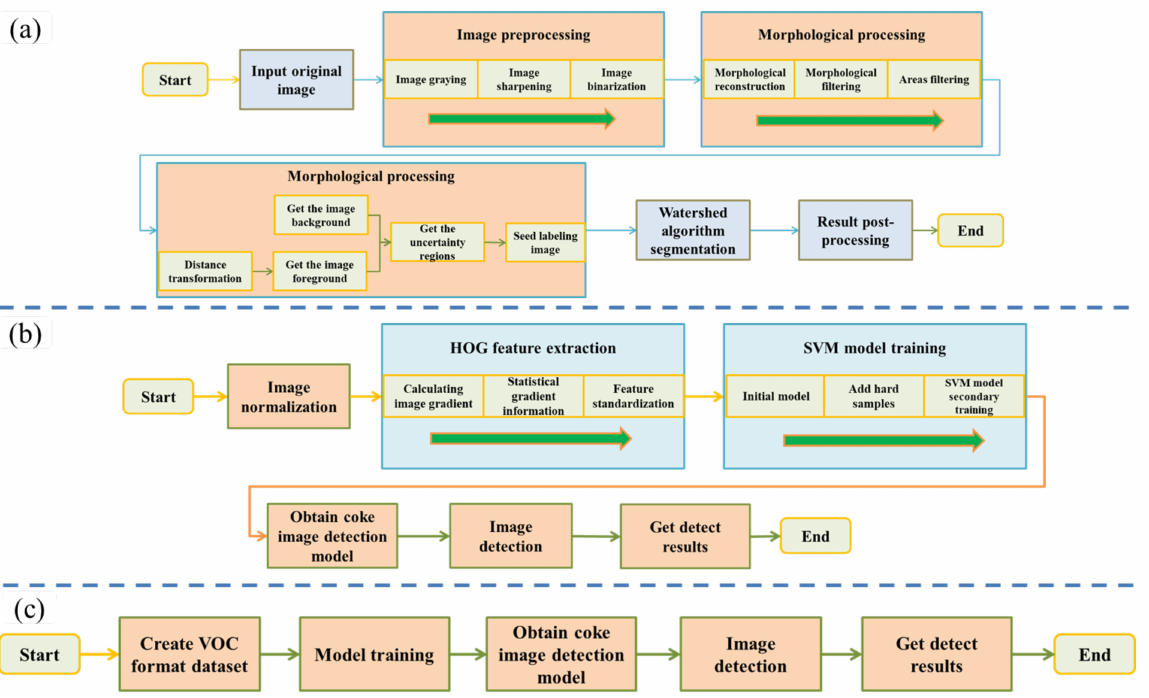
Figure 9. The realization flows for coke image detection. ( a ) MW; ( b ) HOG + SVM; ( c ) Faster R-CNN and